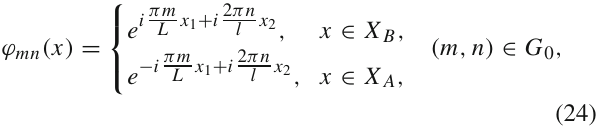
Fig. 7 Domains in the momentum space corresponding to the sub- spaces L and L (cid:3) (shown by dashed disks) (cid:4) (cid:4) H t } = sf { D t } , sf L (cid:3) { sf L { (cid:4) H t } = 0 sf ( L ⊕ L (cid:3) ) ⊥ {